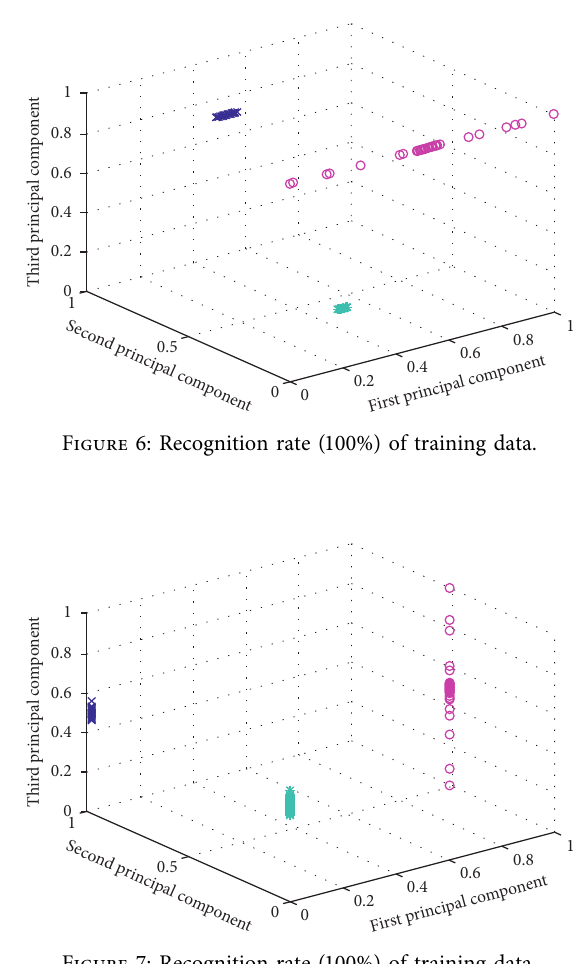
Figure 7: Recognition rate (100%) of training data.